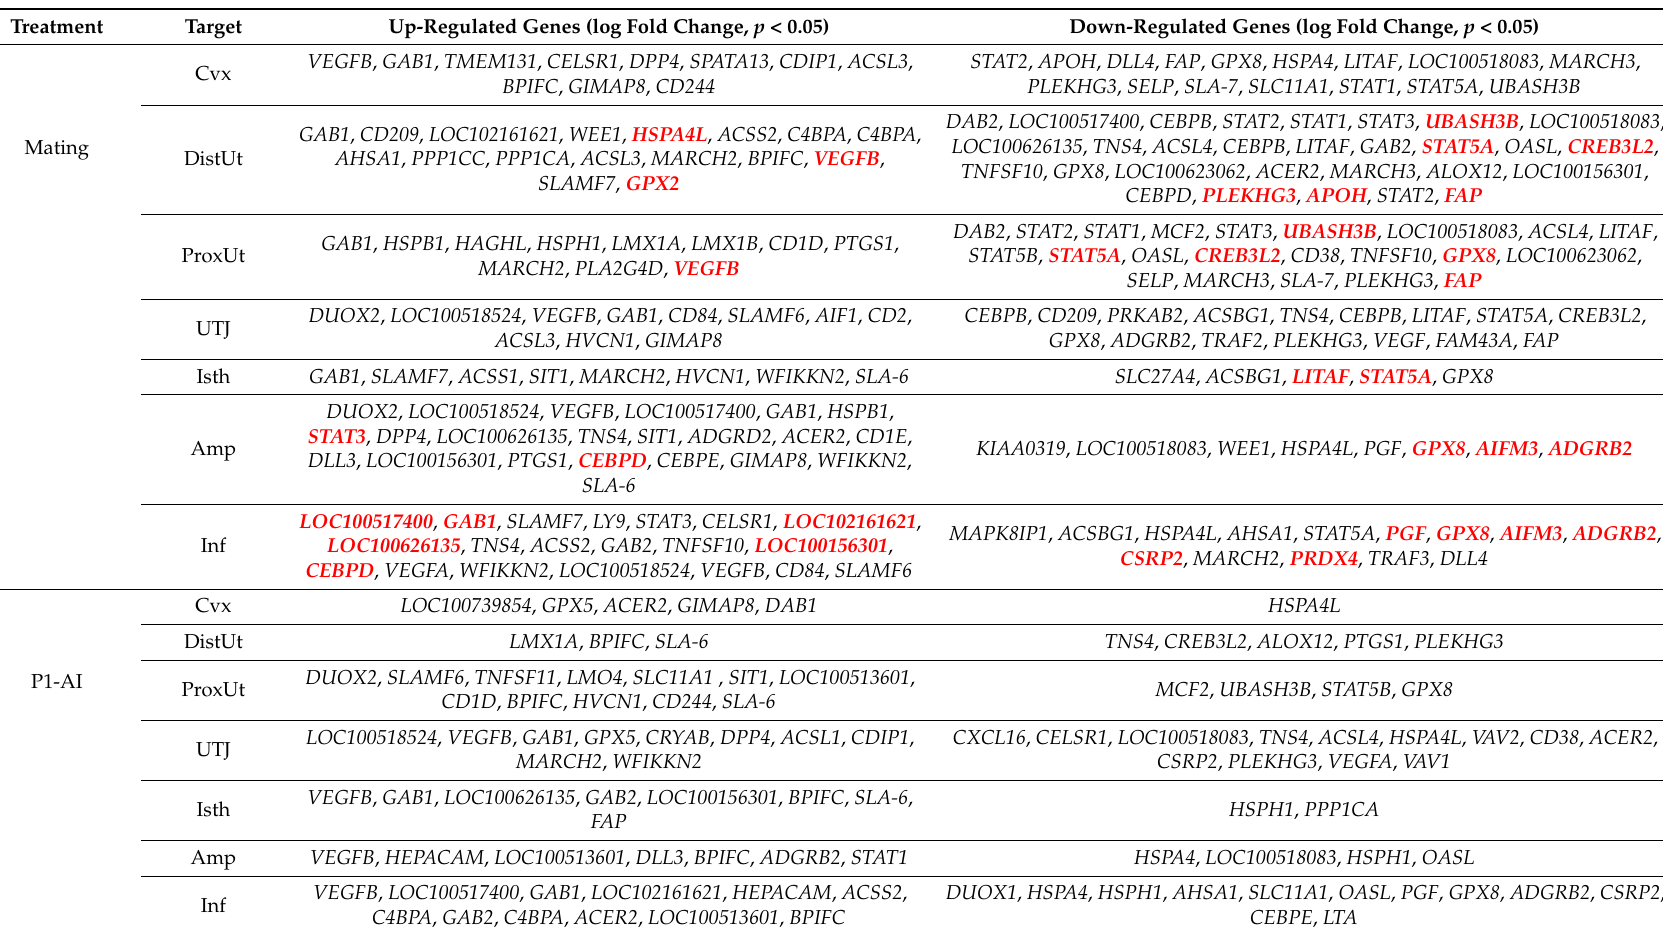
Table 1. Genes belonging to immune processes, up- or down-regulated ( p < 0.05, red: FDR, q < 0.05 ) found in the different segments of the sow genital tract (cervix to infundibulum), 24 h after mating or cervical deposition of the sperm-peak portion (P1-AI), of its SP (SP-P1) or SP from the whole ejaculate